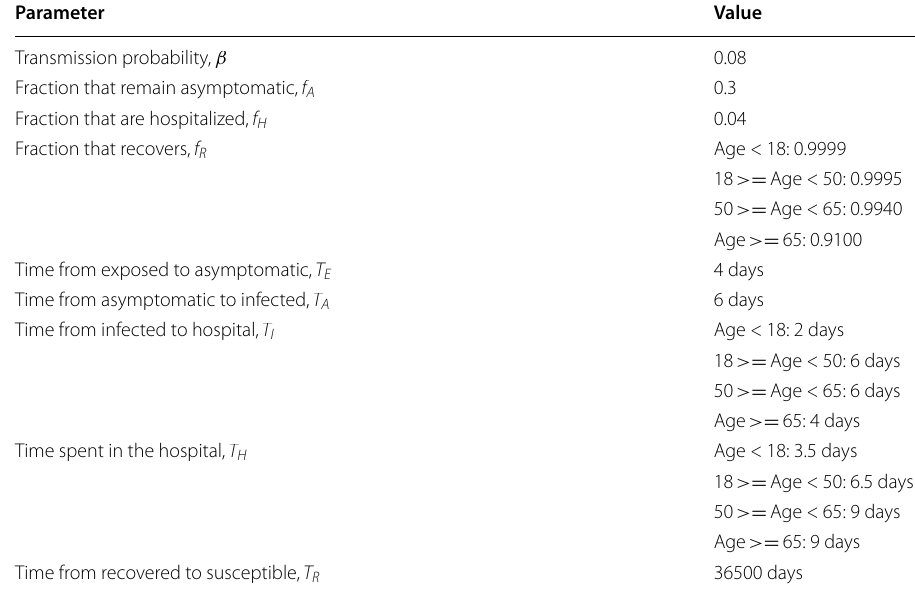
18 > = Age < 50: 0.9995 50 > = Age < 65: 0.9940 Age > = 65: 0.9100 18 > = Age < 50: 6 days 50 > = Age < 65: 6 days Age > = 65: 4 days 18 > = Age < 50: 6.5 days 50 > = Age < 65: 9 days Age > = 65: 9 days